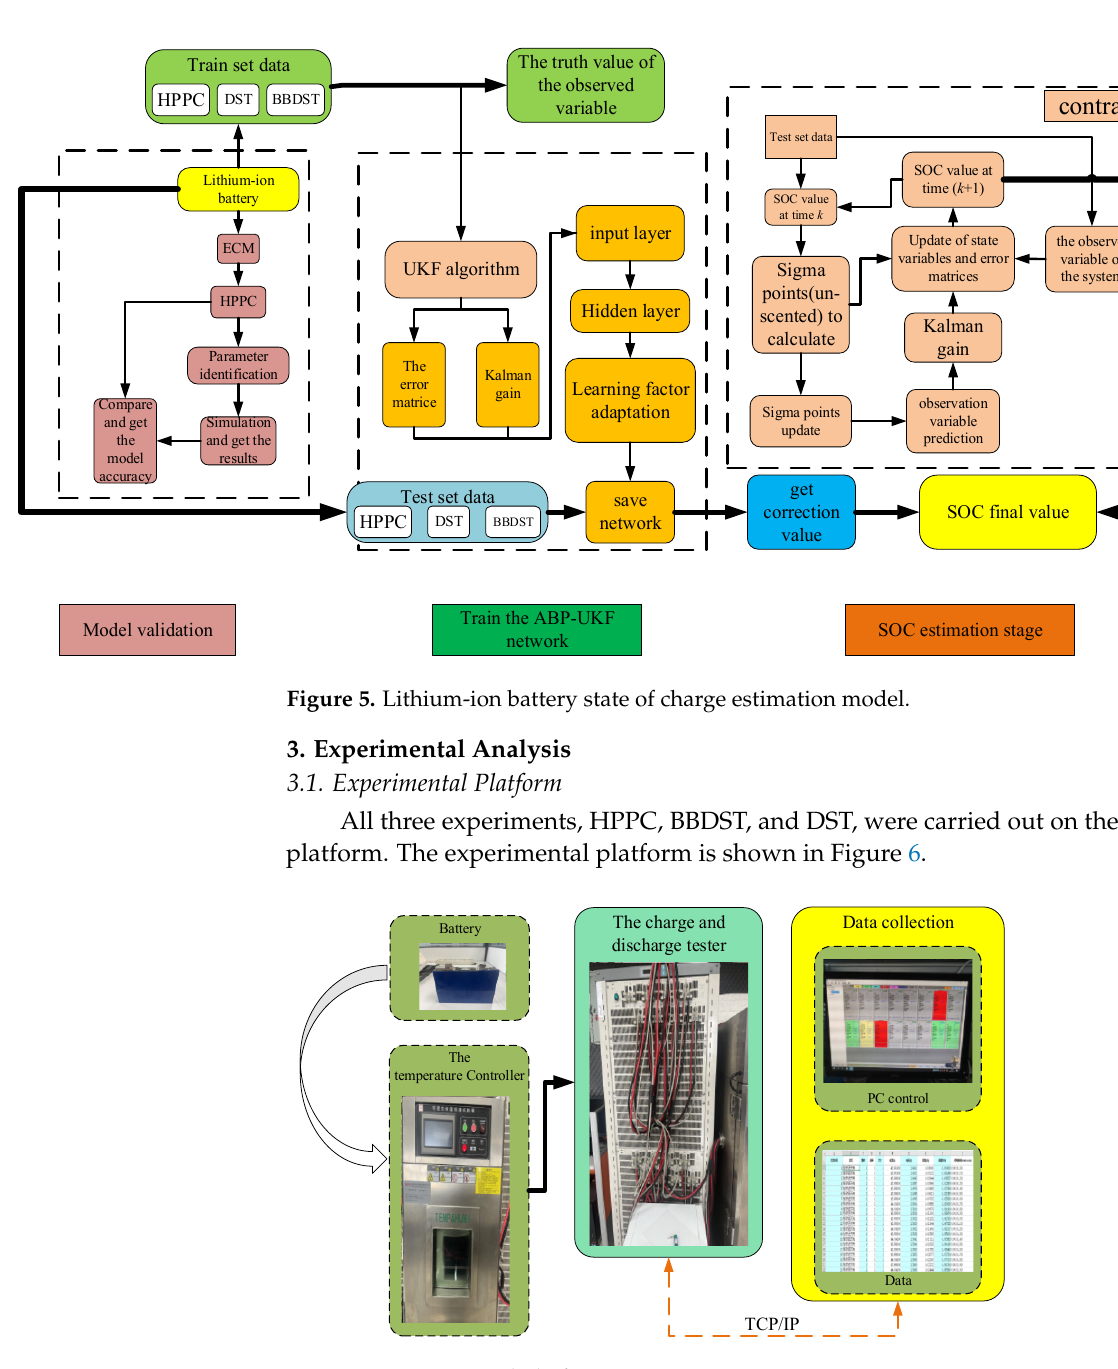
Figure 6. Experimental platform.